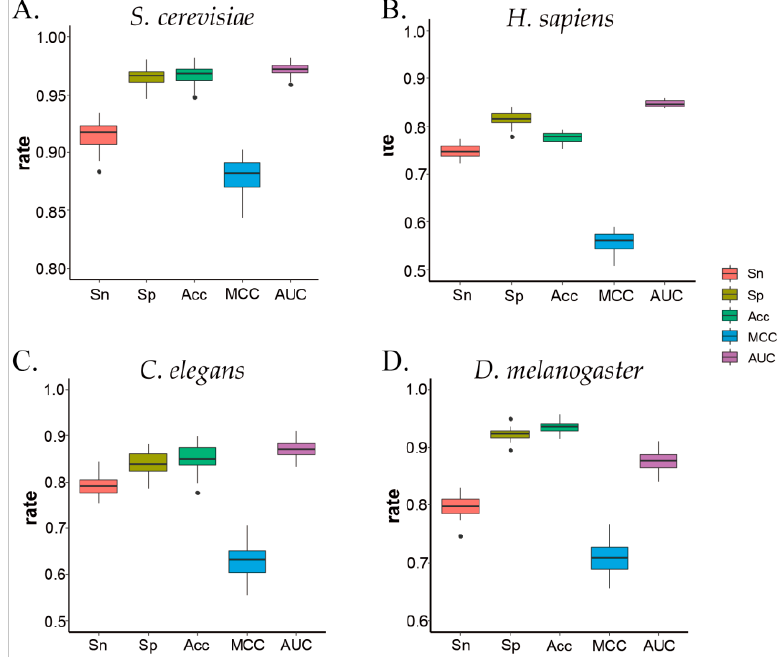
Figure 3. The metrics of prediction by 10-fold cross-validation. ( A – D ) represent the results for S. cerevisiae, H. sapiens, C. elegans, and D. melanogaster , respectively.